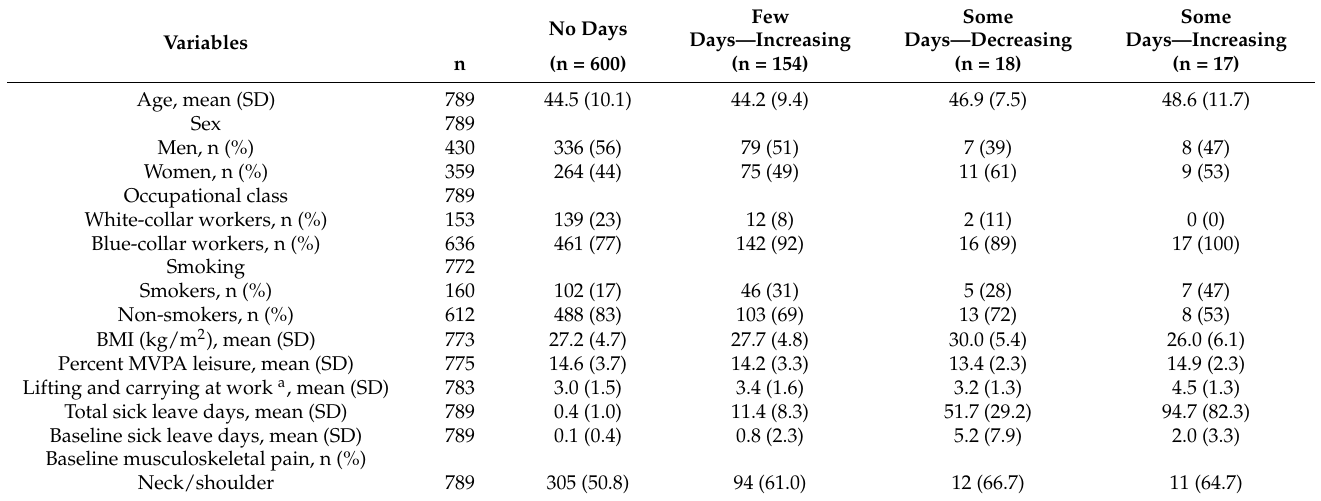
Table 1. Descriptive data in the study sample stratified by sick leave trajectory due to MSP.